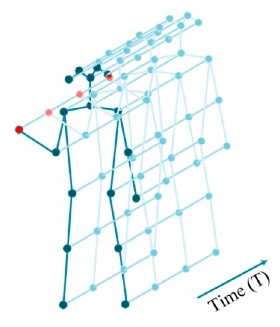
Figure 1. Illustration of spatial-temporal graph of an action clip with multiple frames.